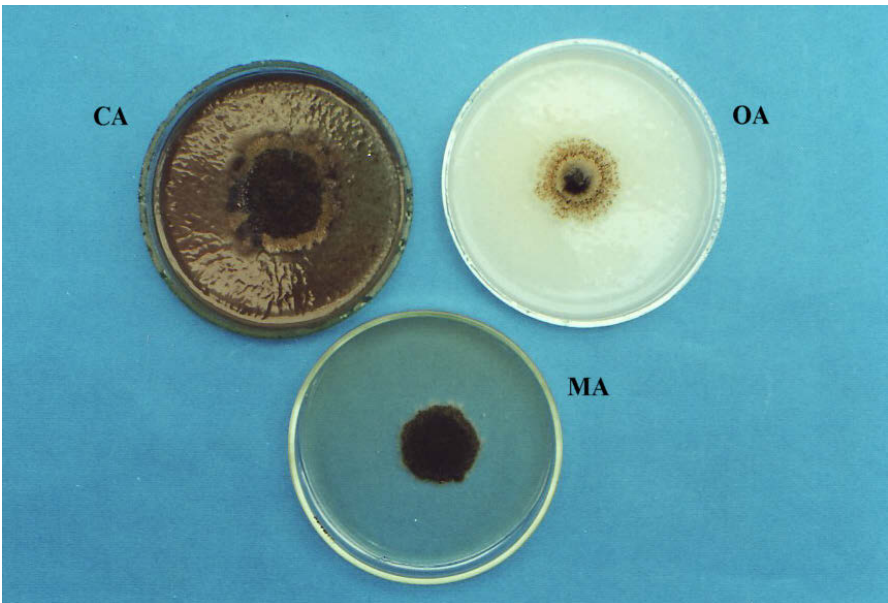
Fig. 1. 14-day-old colonies of Phoma negriana, W 1075 on the standard media. Phot. E. Król.